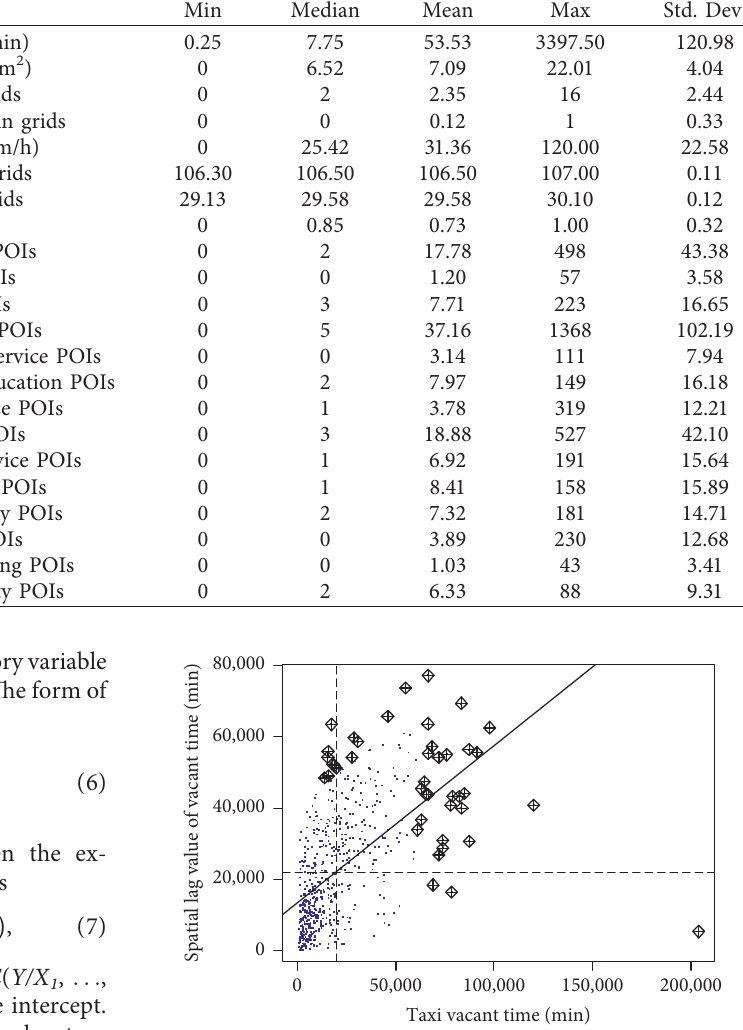
Figure 4: Moran’s I scatter plot of grids. Note: the square symbols represent high impact